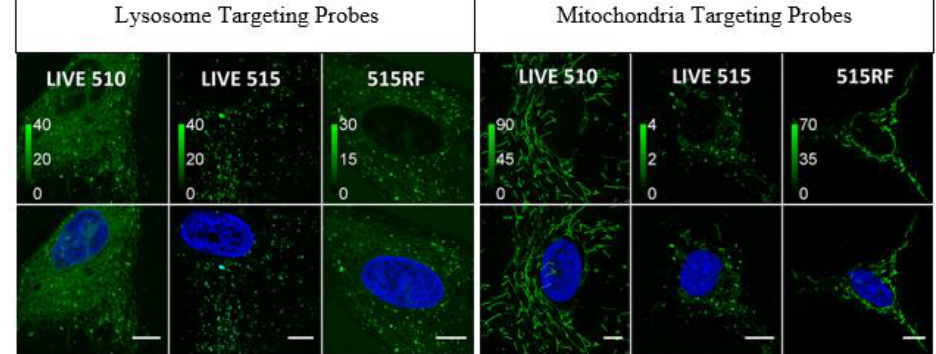
Figure 9. Targeting probes generated with rhodamine dyes 38 – 40 [44]. Confocal imaging of human fibroblasts with Hoechst 33 , 258 (blue) stain for cell nuclei and dyes 38 – 40 conjugated to pepstatin A for lysosome targeting (green) on the left and conjugated to (4-Carboxybutyl)-triphenylphosphonium for mitochondrial targeting (green) on the right; 38 is LIVE 510, 39 is LIVE 515, and 40 is 515RF in 1 μM solution. Scale bars: 10 μm. Figure used with permission from [44]. Copyright 2019 John Wiley & Sons.